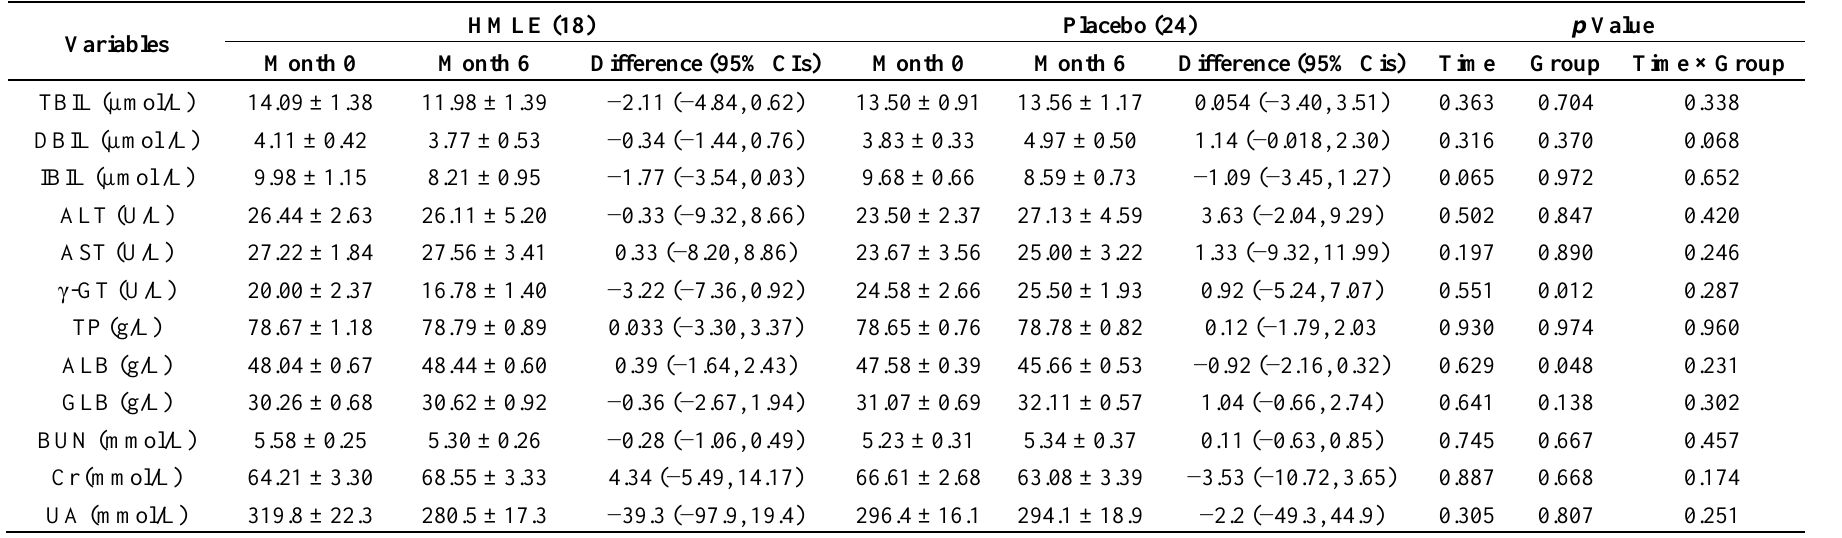
Table 3. Values of liver and renal function variables before and after